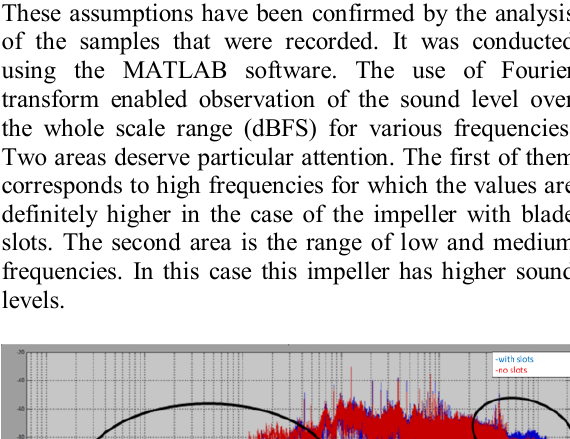
Fig. 8. Noise measurements